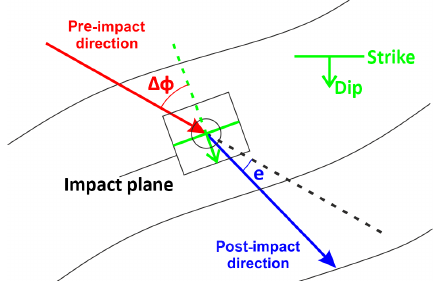
Figure 11. Release angle versus initial velocity for the first parabolic section ( δx = 10.75m, δy = 8.33m).